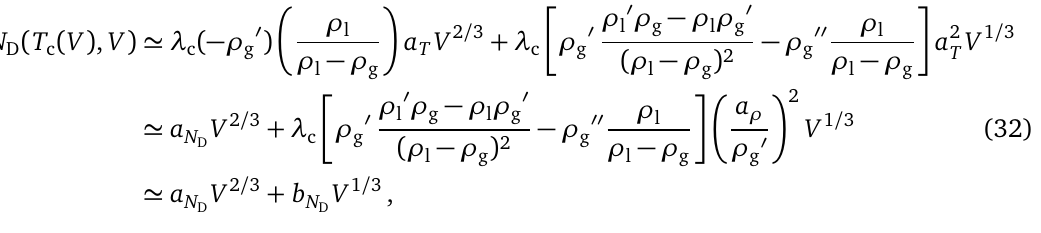
Figure 11: Scaling of the droplet size N temperature (blue crosses and yellow circles) and at fixed density (red squares). The analytic prediction is plotted to leading order [ black, solid, Eq. (11) ] along with its temperature expansion to second order [ red, dashed, Eq. (32) ] , as is necessary to describe the fixed-density data. The amplitudes a grand canonical reference